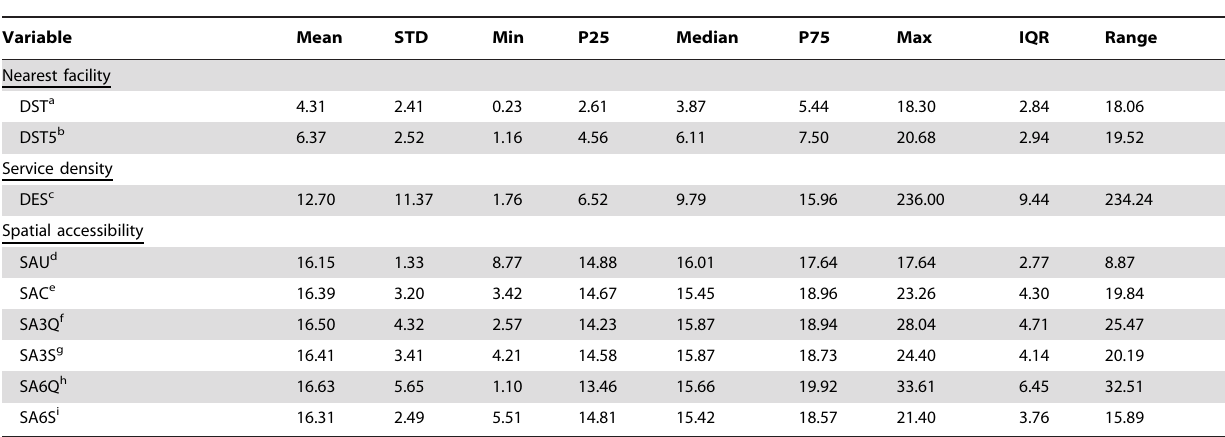
Table 2. Distribution of nine GIS-based measures in St.